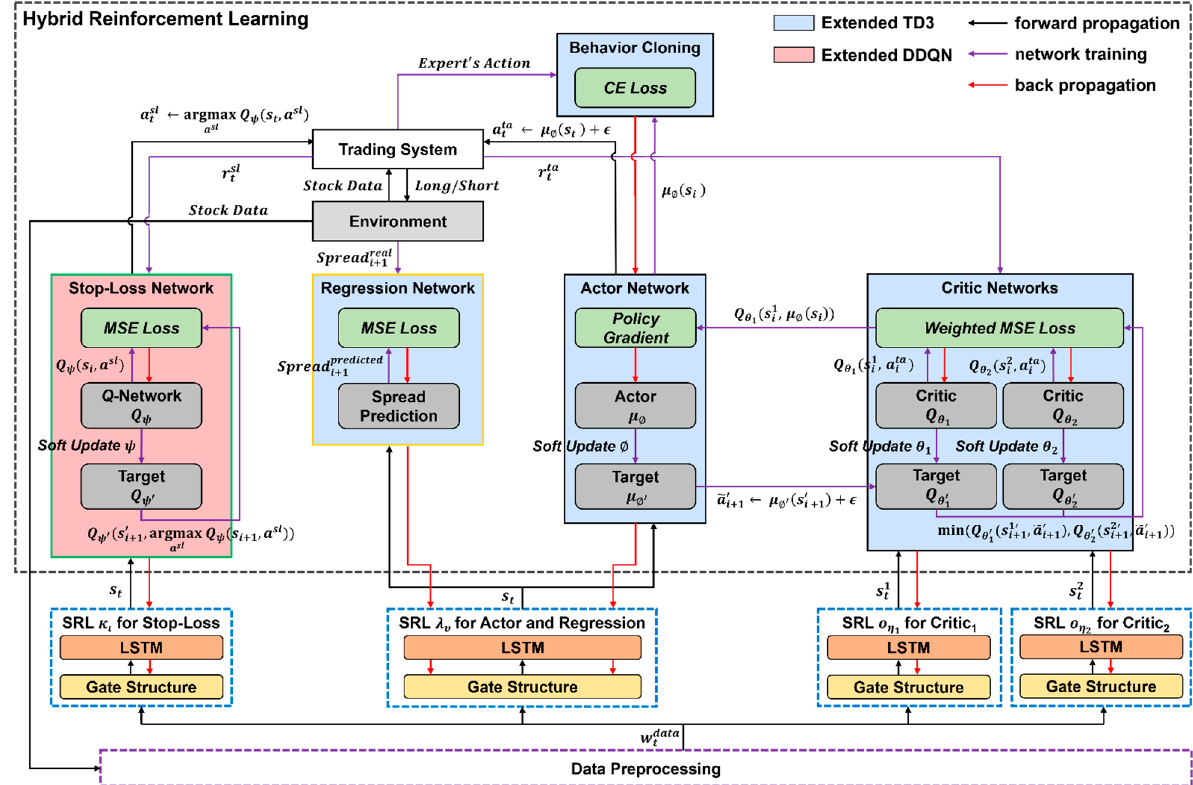
Figure 7. Architecture of the hybrid deep reinforcement